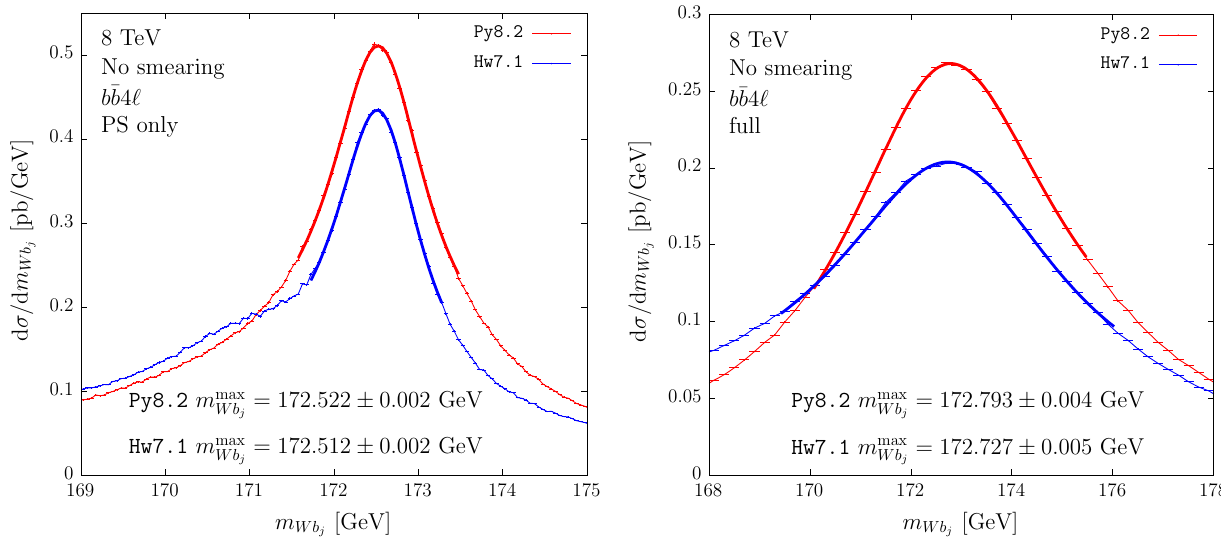
Fig. 12 d σ/ dm Wb distribution obtained by showering the b ¯ b 4 (cid:4) results with Pythia8.2 and Herwig7.1 , at parton-shower level (left) and j with hadronization and underlying events (right)